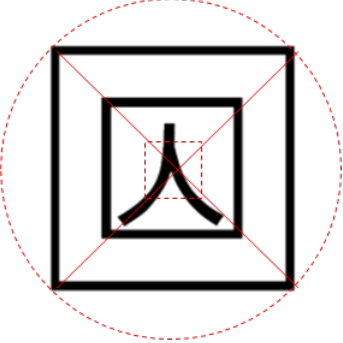
Figure 9. Creation of marker‟s focal point-based